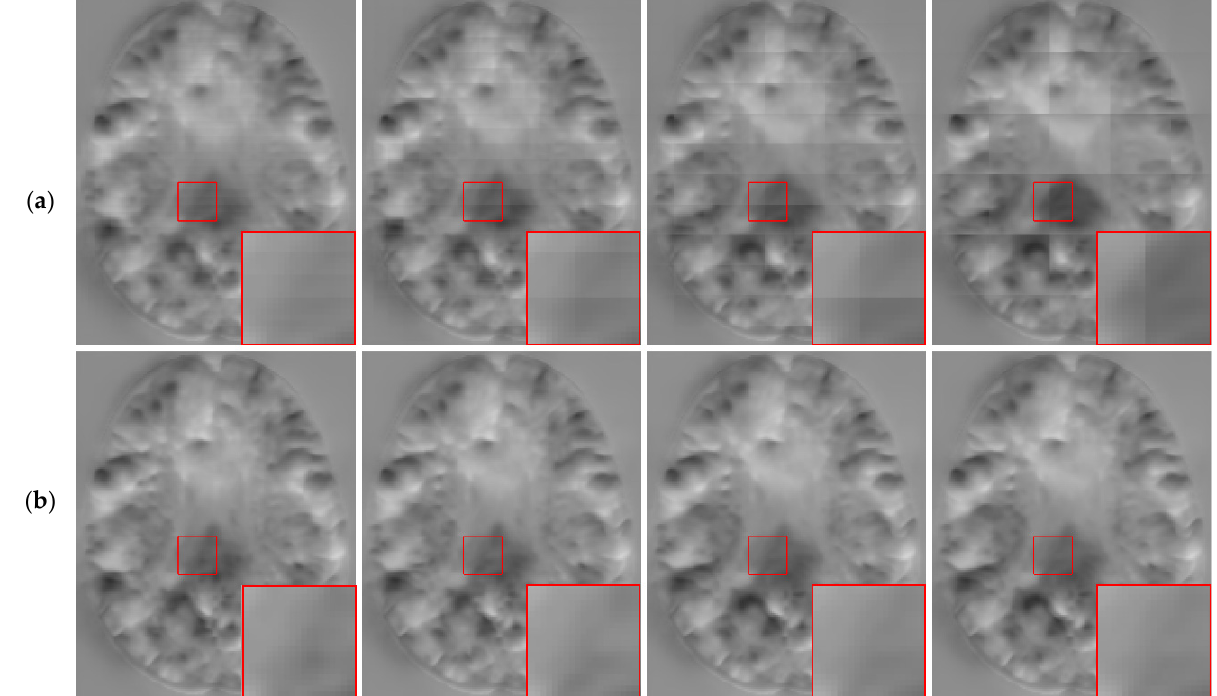
Figure 10. The results of different stride for AAW ( a ) and proposed method ( b ). The strides from left to right are 4 × 4 × 4, 8 × 8 × 8, 16 × 16 × 16 and 32 × 32 × 32.